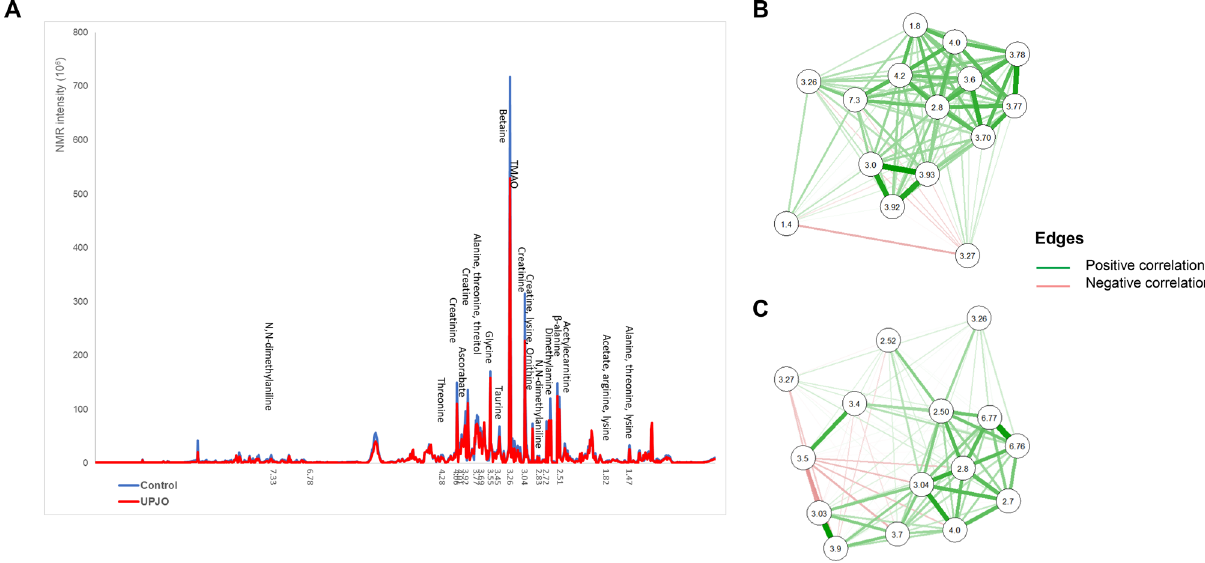
Figure 3. ( A ) Average of NMR spectra from UPJO (red) and control (blue) and bucket’s annotation from SPLS-DA. ( B )–( C ) Correlation network of the variables from NMR. ( B ) UPJO versus TD (C) UPJO versus controls. The color indicate link between variables—red for anti-correlation and green for correlation. Thickness of lines demonstrates the intensity of the correlation. Correlation network was performed using qgraph R